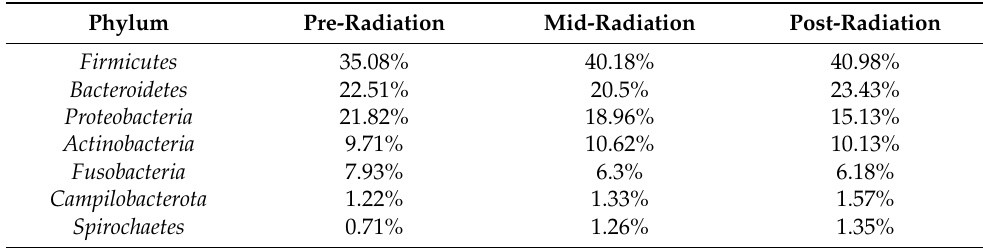
Table 2. The relative abundance profile (Phylum level) of the total oral microbiome at three different time points.